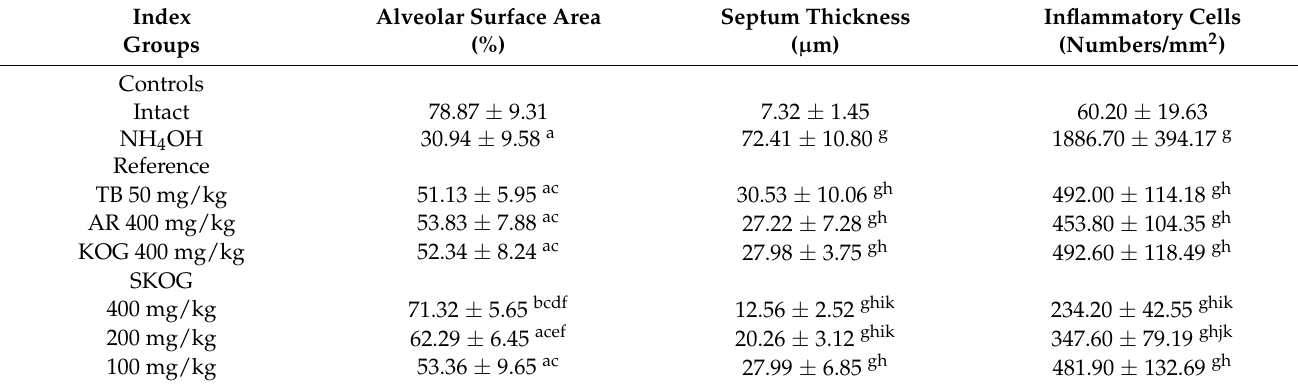
Table 2. Effects of AR, KOG, and SKOG on the histomorphometry of lung—alveolar regions in